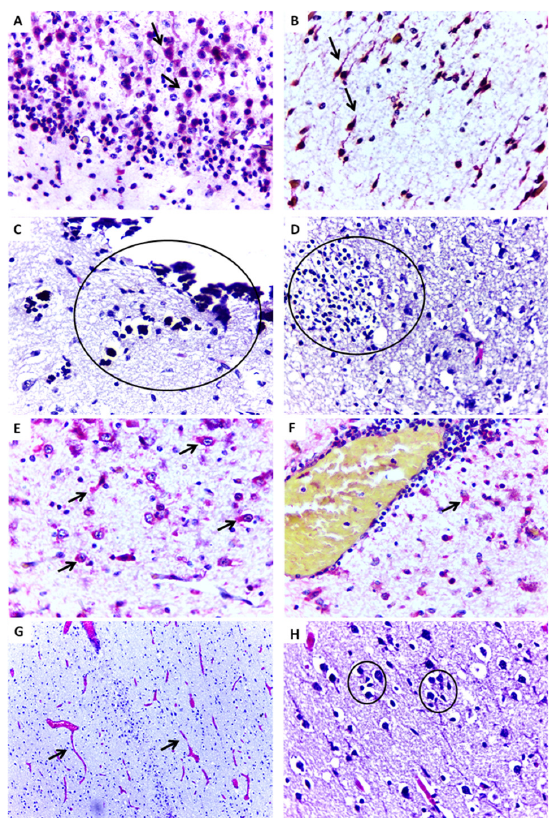
Figure 2. Representative histopathological changes and positive immunostaining in central nervous tissue of ZIKV-positive microcephaly cases by ZIKV. ( A , B ) Cellular disorganization in the cortical layer and positive immunostaining (arrow) for ZIKV antigen in neurons (Case 4) (IHC, SAAP, 400×). ( C ) Foci of dystrophic calcification in parenchyma with degenerative necrotic lesion (Case 6) (HE, 400×).( D ) Gliosis in parenchyma with degenerative necrotic lesion (Case 6) (HE, 400×). ( E , F )Positive immunostaining for ZIKV in neurons and astrocytes with perivascular inflammatory infiltrate (Case 6) (IHC, SAAP, 400×). ( G )Significant vascular proliferation, edema and vessel congestion (arrows) (Case 11) (HE, 100×). ( H ) Pyramidal neurons of the cerebral cortex with neuronophagy, satelitosis, and gliosis (circles) (Case 11) ( HE, 400×).